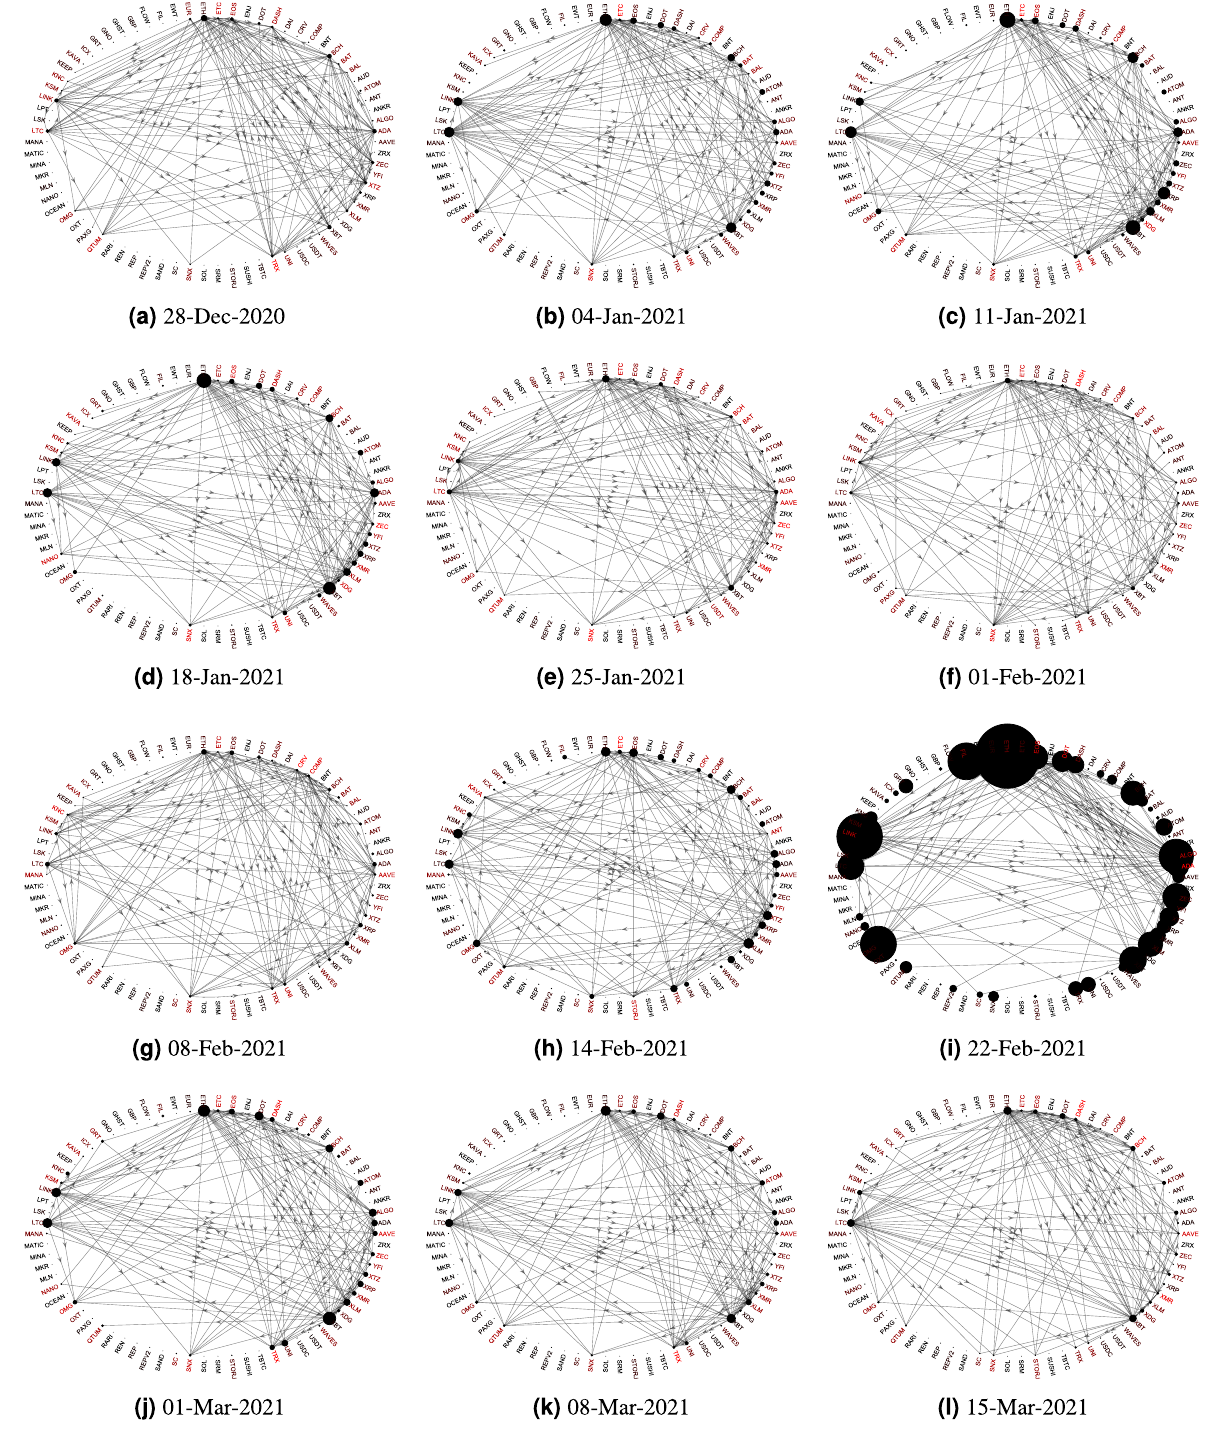
Figure 3. The USD network of pairwise Granger causality for weekly time windows. The size of the nodes represents the total out strength of that node in that window or, in other words, how much that node influences the network, while the label color (from black to red) is the total in strength, that is how much that node is influenced by the rest of the